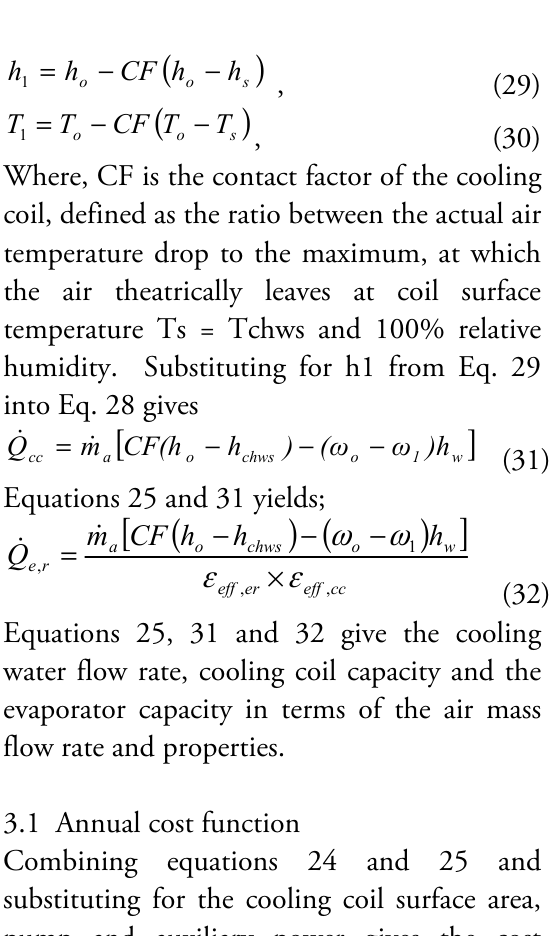
Fig. 3: Moist air cooling process on the psychrometric